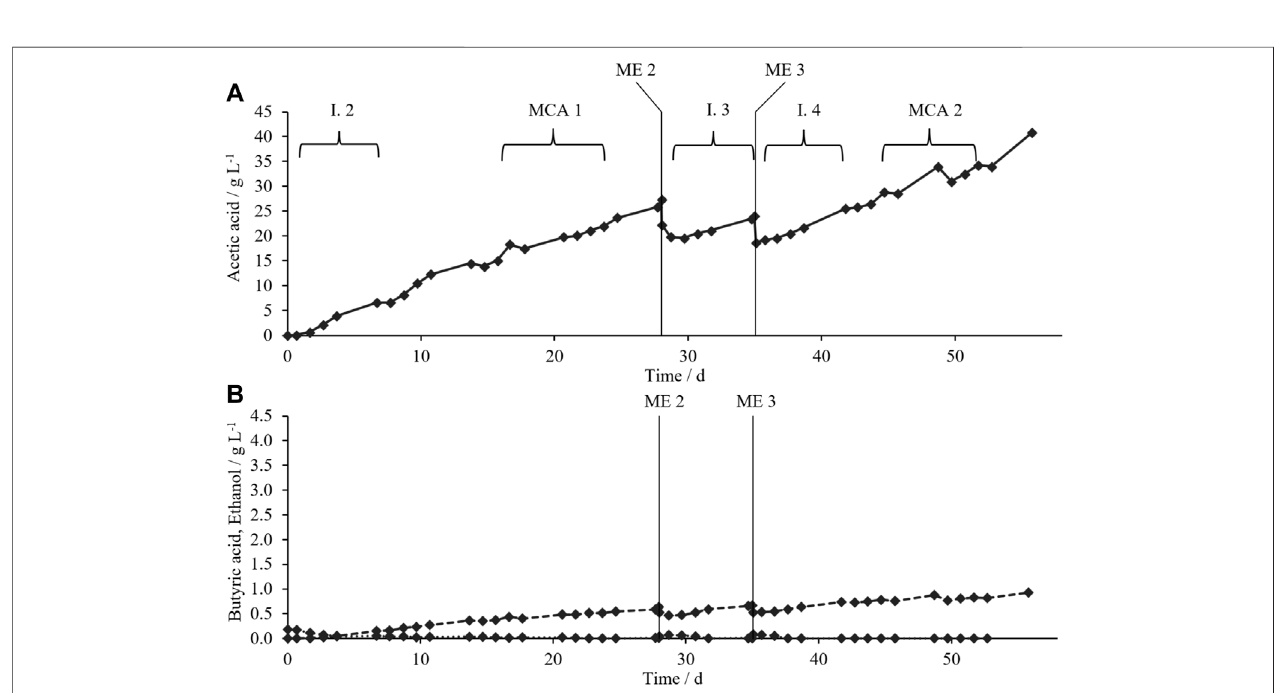
FIGURE 4 | (A) AAC (solid lines) and (B) BAC (dashed lines) and ethanol concentration (dotted lines) during acetic acid production in TB2 (black diamonds) with MEs 2 – 3 (vertical lines); time intervals (I.) for calculation of AAPR after MEs; time intervals for microbial composition analysis